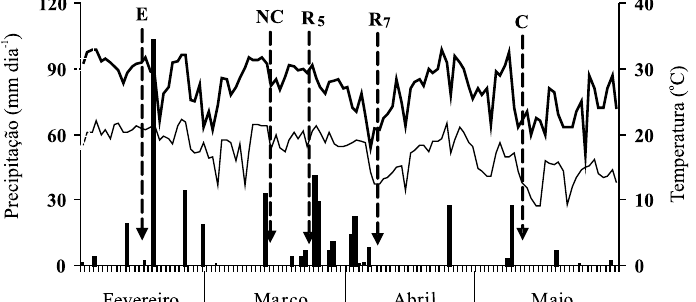
Figura 1. Precipitação pluvial ( ), temperatura máxima ( ) e temperatura mínima ( ) obtidas na área experimental durante o período de fevereiro a maio de 2010 e datas de emergência (E), aplicação do nitrogênio em cobertura (NC), estádio de pré-floração (R vagens (R ) e colheita (C) da cultura do 7